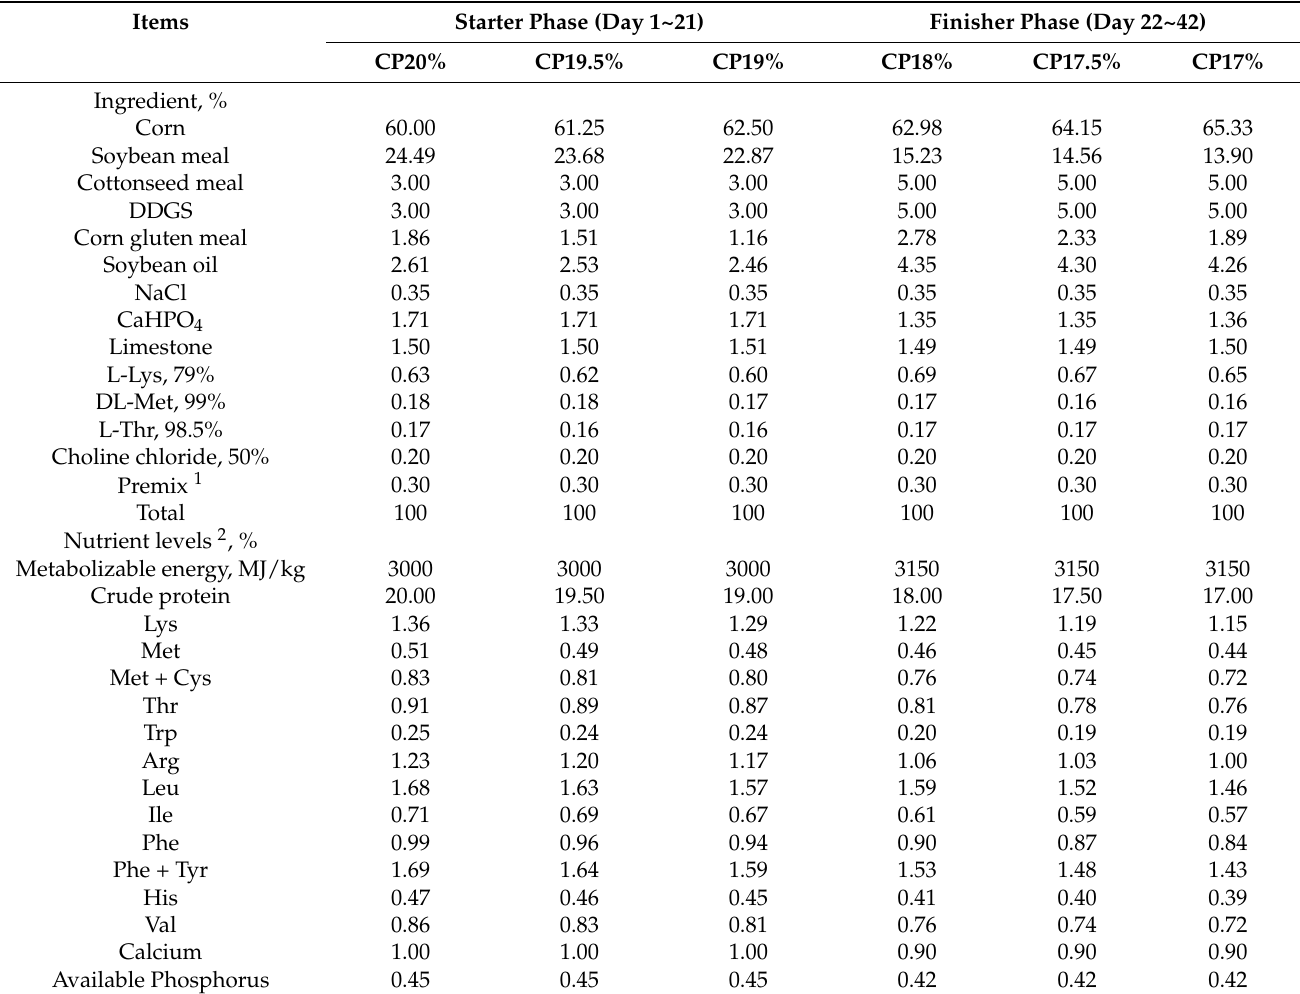
Table 2. Ingredient composition and nutrient content of basal diets (dry matter